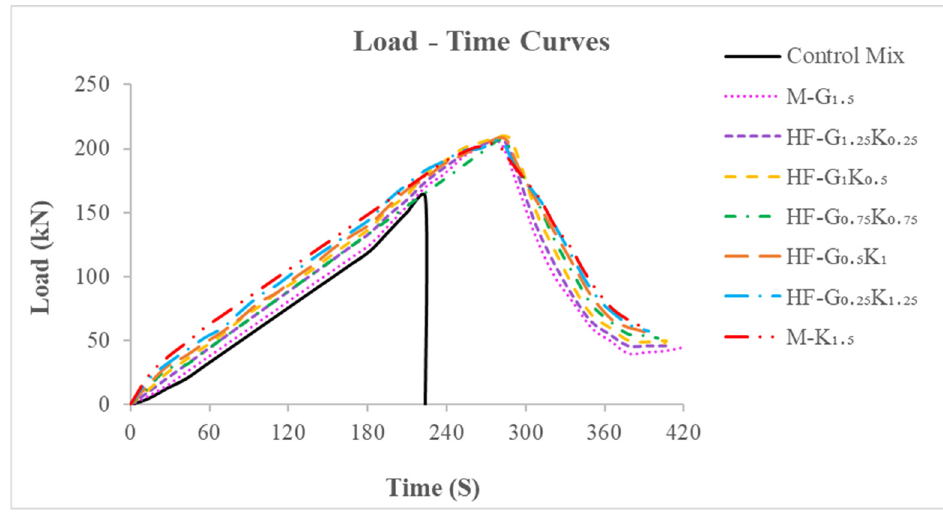
Figure 11. Load–time curves of concrete specimens.